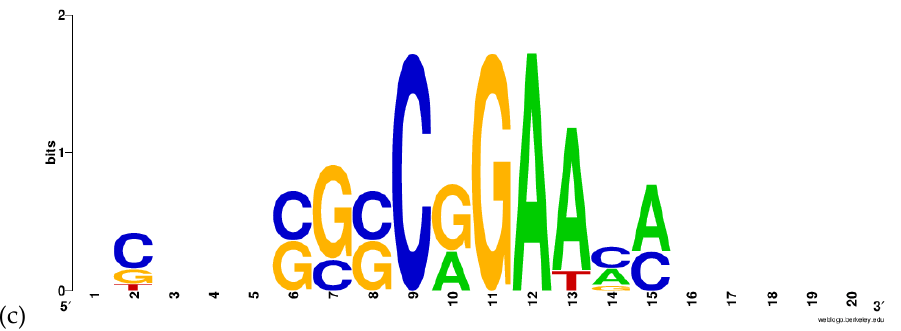
Figure 3. Sequences obtained with Gibbs Recursive Sampling . ( a ) The first motif was determined as the closest to the optimal alignment. ( b ) The second motif obtained was formed by events that occur with a probability greater than 50%. ( c ) The third motif obtained by the software was limited to three motifs per sequence and three different motifs in total. The schematic figures were created with WEBLOGO v 2.8.2.